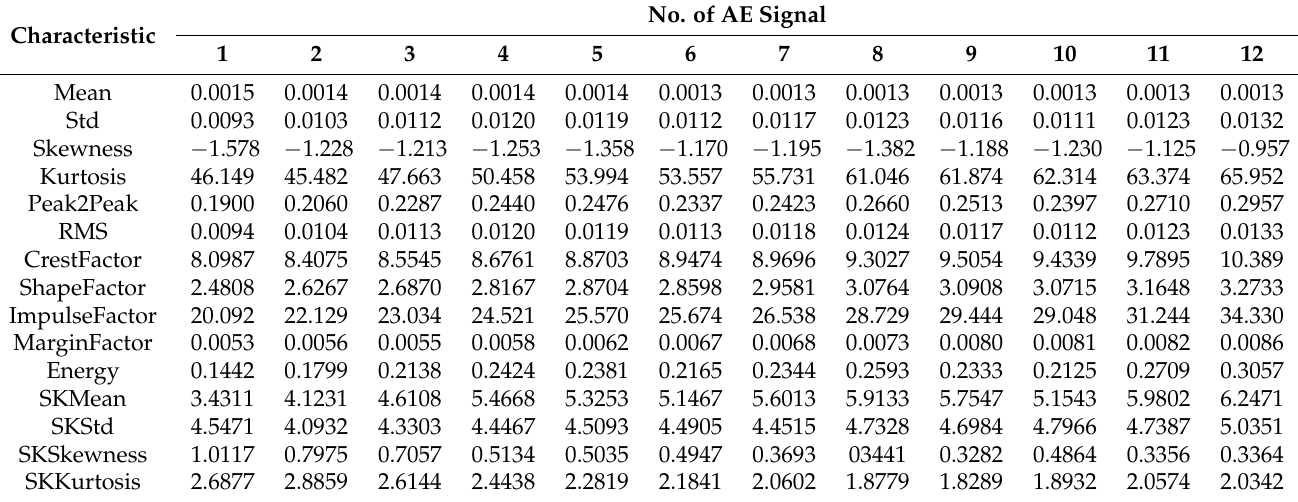
Table 2. Statistical characteristics of AE signals in the time and frequency domains.